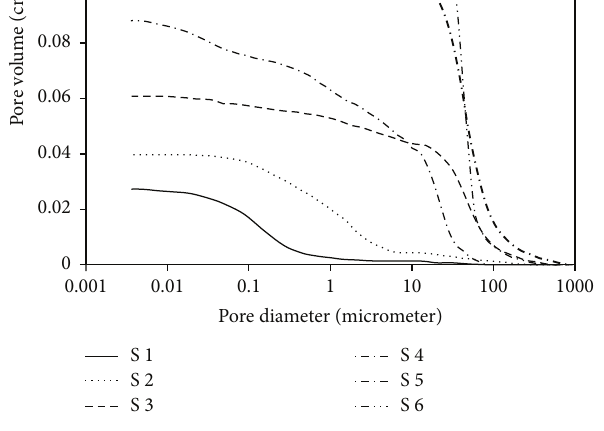
Figure 2: Pore size distribution.